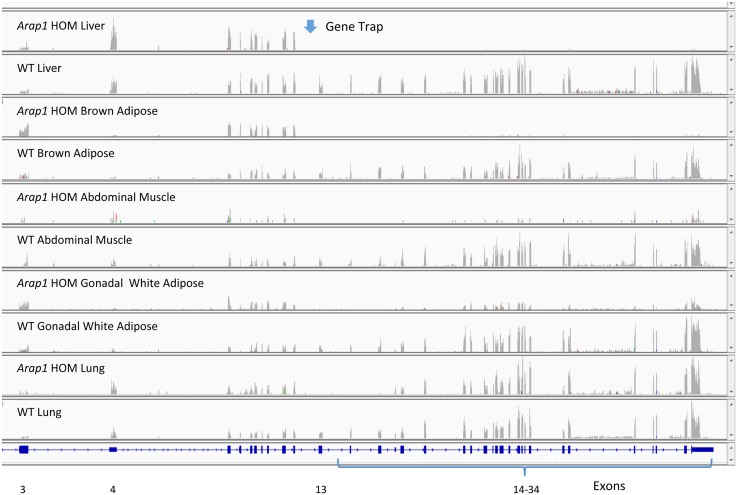
Reads for Arap1 TRAP HOM and WT liver, brown adipose (interscapular), abdominal muscle, gonadal white adipose and lung mapping to Arap1 genomic sequence.Exons 1 &2 are not shown because either very few or no reads mapped to those exons from the sequenced libraries. The TRAP vector targeting Arap1 places the gene trap 5’ to exon 13. Liver and brown adipose tissue have no reads mapping 3’ to exon 12. However, for HOM abdominal muscle, gonadal adipose, and lung, after skipping exons 13, 14, 15 and 16, there are Arap1 reads in the more distal exons, albeit at a lower count than those found in WT tissues.